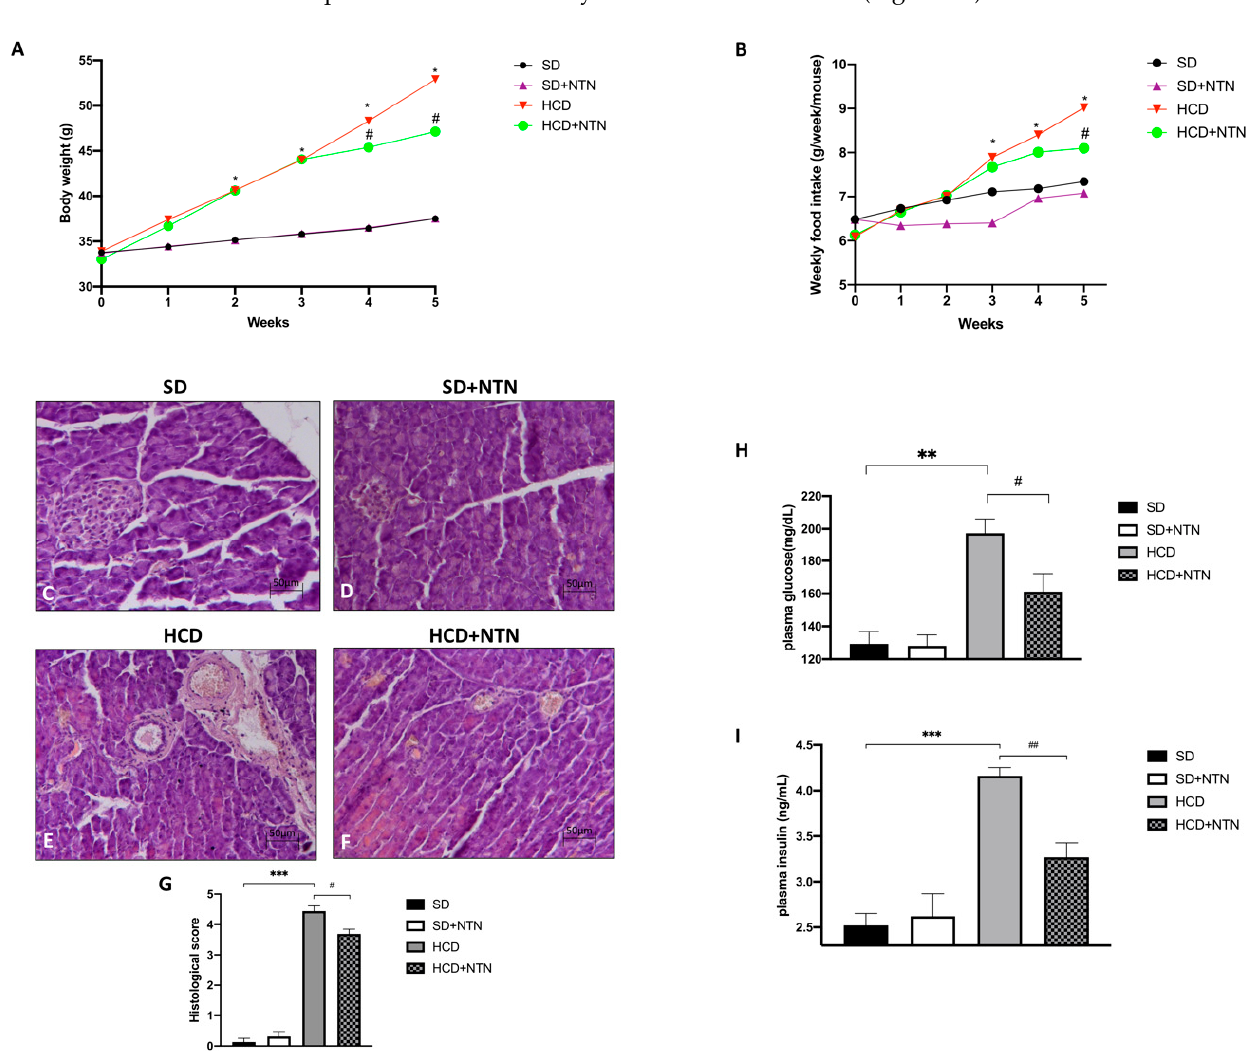
Figure 2. Effects of NTN on body weight, food intake, histological damage of the pancreas and glucose-insulin levels in HCD intolerant mice. A slight increase in body weight and food intake was detected in HCD-mice compared to the control group ( A , B ); NTN administration reduced both parameters in HCD mice ( A , B ). Extensive neutrophil infiltration and tissue damage were observed in mice fed with HCD ( E , G ) compared to SD and SD + NTN animals ( C , D , G ). Administration of NTN was able to significantly counteract the extent of tissue damage and neutrophil infiltration in HCD mice ( F , G ). NTN administration reduced both glucose and insulin levels ( H , I ). Data are representative of at least three independent experiments. Values are means ± SEM. One-Way and Two-Way ANOVA test. * p < 0.05 vs. SD; ** p < 0.01 vs. SD; *** p < 0.001 vs. SD; # p < 0.05 vs. HCD; ## p < 0.01 vs.